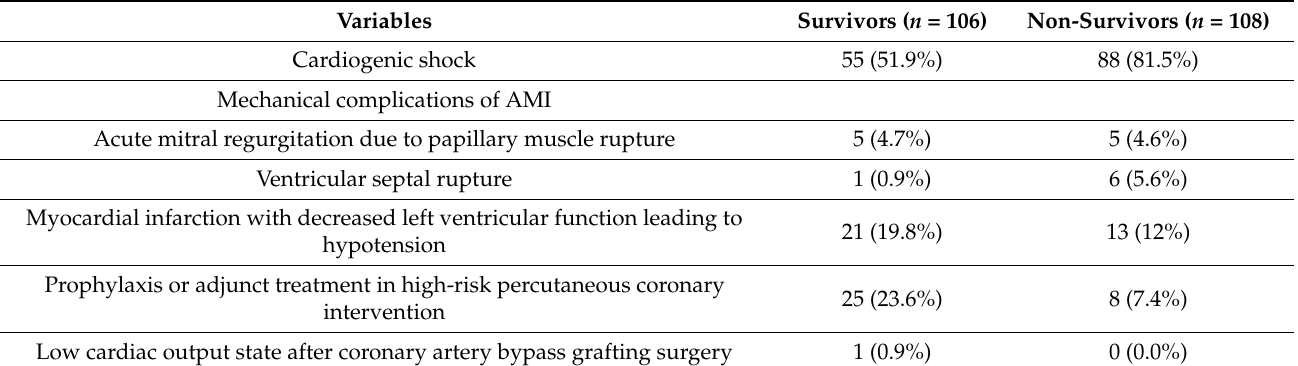
Table 3. Indications for an IABP in the study